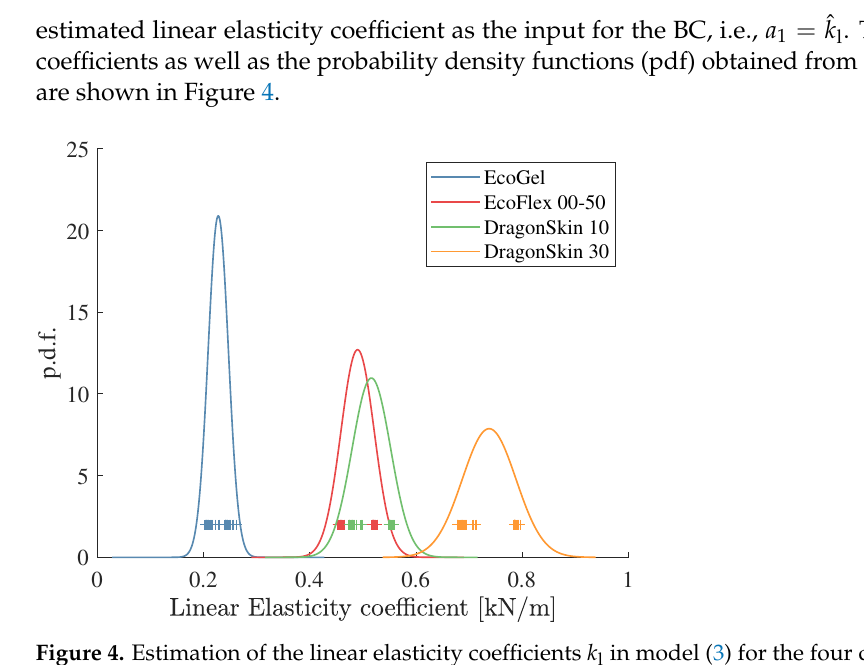
Figure 4. Estimation of the linear elasticity coefficients k l in model (3) for the four different rubber samples and their normal probability density functions.